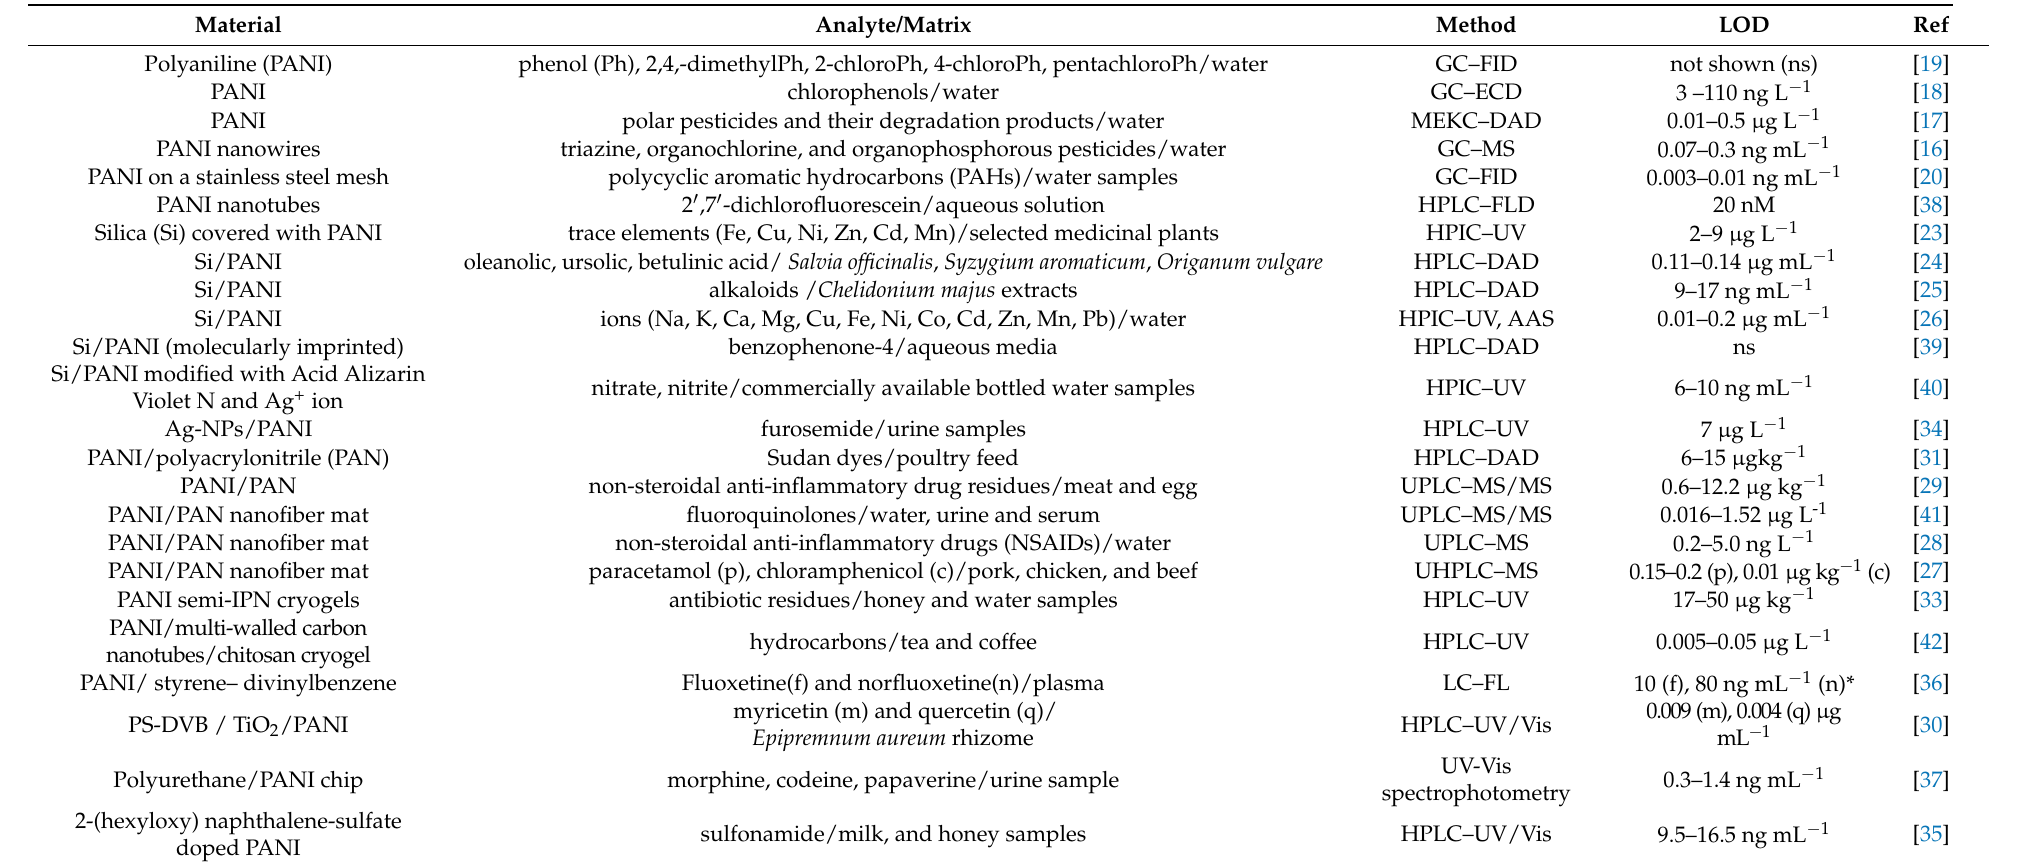
Table 1. Application of polyaniline and polyaniline-based material as sorbents in the SPE/ µ SPE